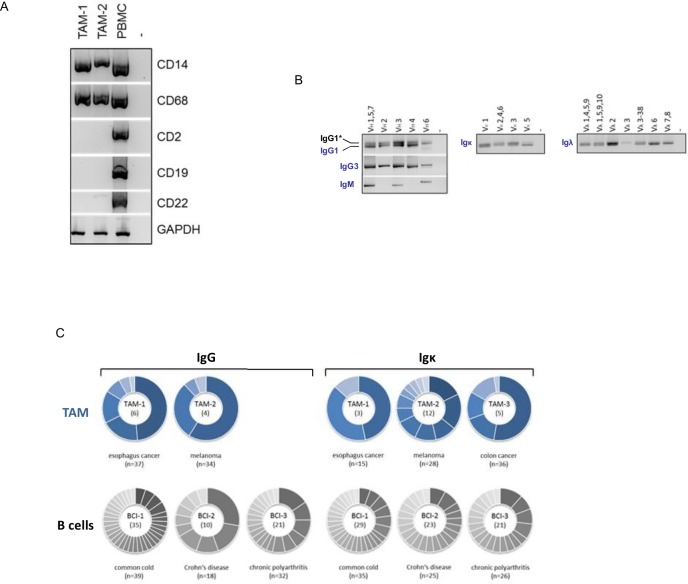
Tumor-associated macrophages express restricted Ig repertoires.(A) RT-PCR expression profiling of TAM cell preparations for B cell (CD19, CD22), T cell (CD2) and monocyte/ macrophage marker genes (CD14, CD68), respectively, demonstrates absence of detectable quantities of B or T cells. The results shown for tumor patients TAM-1 and TAM-2 are representative of all TAM cell preparations. PBMC, peripheral blood mononuclear cells (positive control); -, no template added. (B) CD14+ macrophages isolated from a human melanoma patient (TAM-2) express combinatorial heavy (IgG1, IgG3, IgM) and light chain genes (Igκ,Igλ). Diagnostic amplification products span VH−C, and Vκ-C and Vλ-C segments, respectively, and were generated using consensus primers for the indicated variable chains (VHi, Vκj, Vλi). -, no template added. Note expression of an additional IgG1 transcript (IgG1*, +97 bp) which is generated by intron retention within the CH gene and gives rise to an alternative C-terminus (unpublished data). (C) IgG and Igκ repertoire diversities in tumor macrophages from patients TAM-1 to TAM-3. Sector areas correspond to the relative frequency of individual clonotypes within a given Ig CDR3 repertoire and are sorted by size. Each sector within a circle chart represents a unique CDR3 variant and the number of identified variants is shown in the center. Clonotype frequencies in B cells from patients with acute and chronic inflammatory diseases are shown for reference (BCl-1, BCl-2, BCl-3). Note that TAM express less diverse IgG and Igκ repertoires than B cells from patients with inflammatory diseases. The total number of Sanger sequenced clonotypes are shown at the bottom of each pie chart.